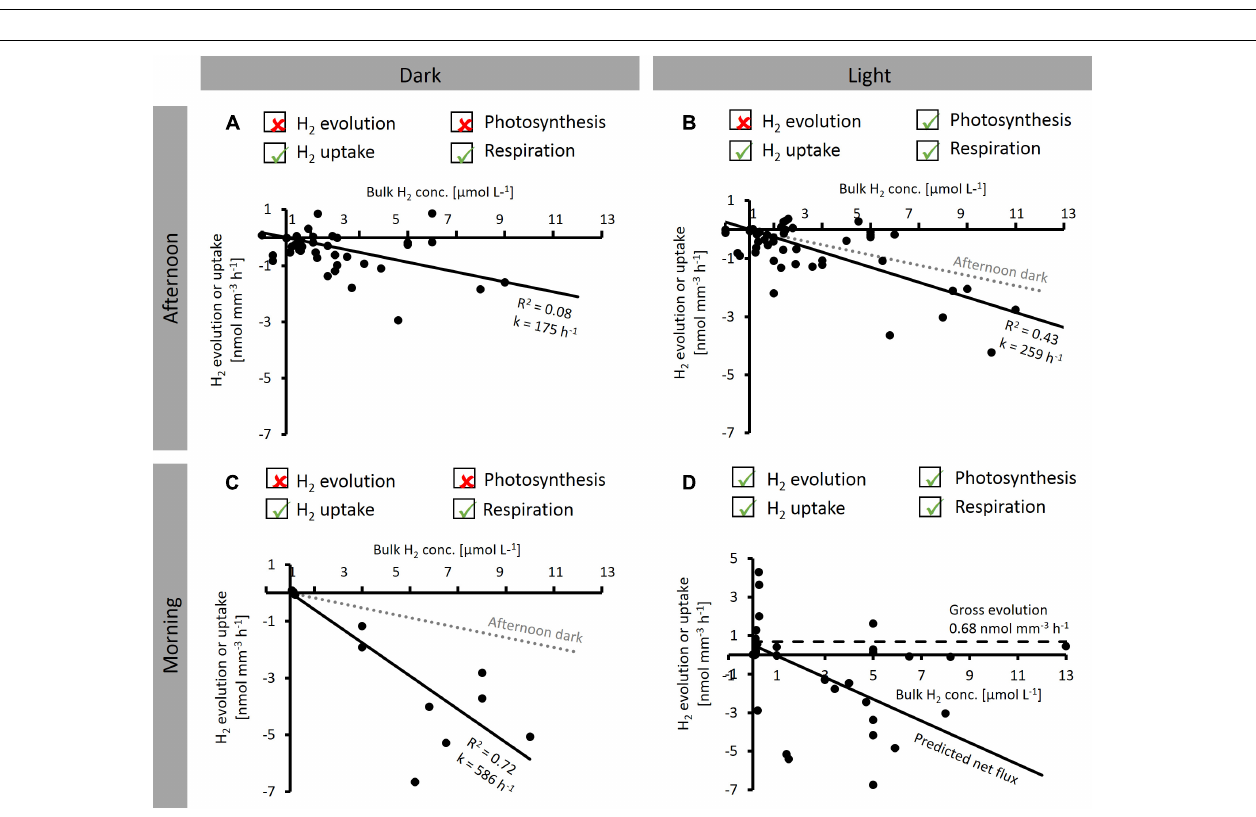
FIGURE 4 | H 2 and O 2 evolution rates measured simultaneously by using two electrodes on the same Trichodesmium colonies in dark (A) and light (B) . All measurements were conducted after 2 pm. Note that all data shown are net rates, with positive numbers reflecting net evolution of H 2 or O 2 by a specific colony, and negative numbers reflecting net uptake of H 2 or O 2 , respectively. (A) shows a linear regression (solid line) and 95% confidence interval of the fit (dashed lines).